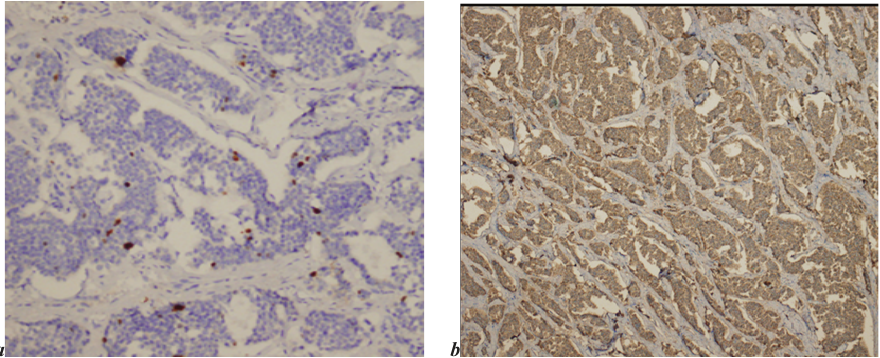
a b Figure 7 : Immunohistochemical staining (IHC) of pancreatic neuroendocrine tumor: (a) IHC staining for Ki67 × 40 and (b) IHC for chromogranin ×